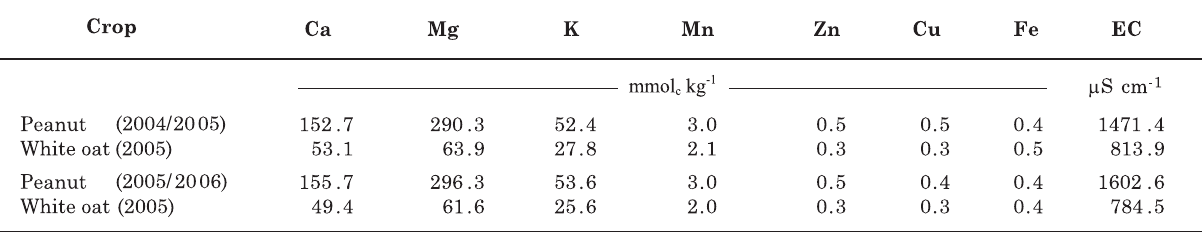
Table 4. Contents of water-soluble nutrients and electrical conductivity (EC) in the plant extract of peanut and white oat at flowering in 2004/2005 and